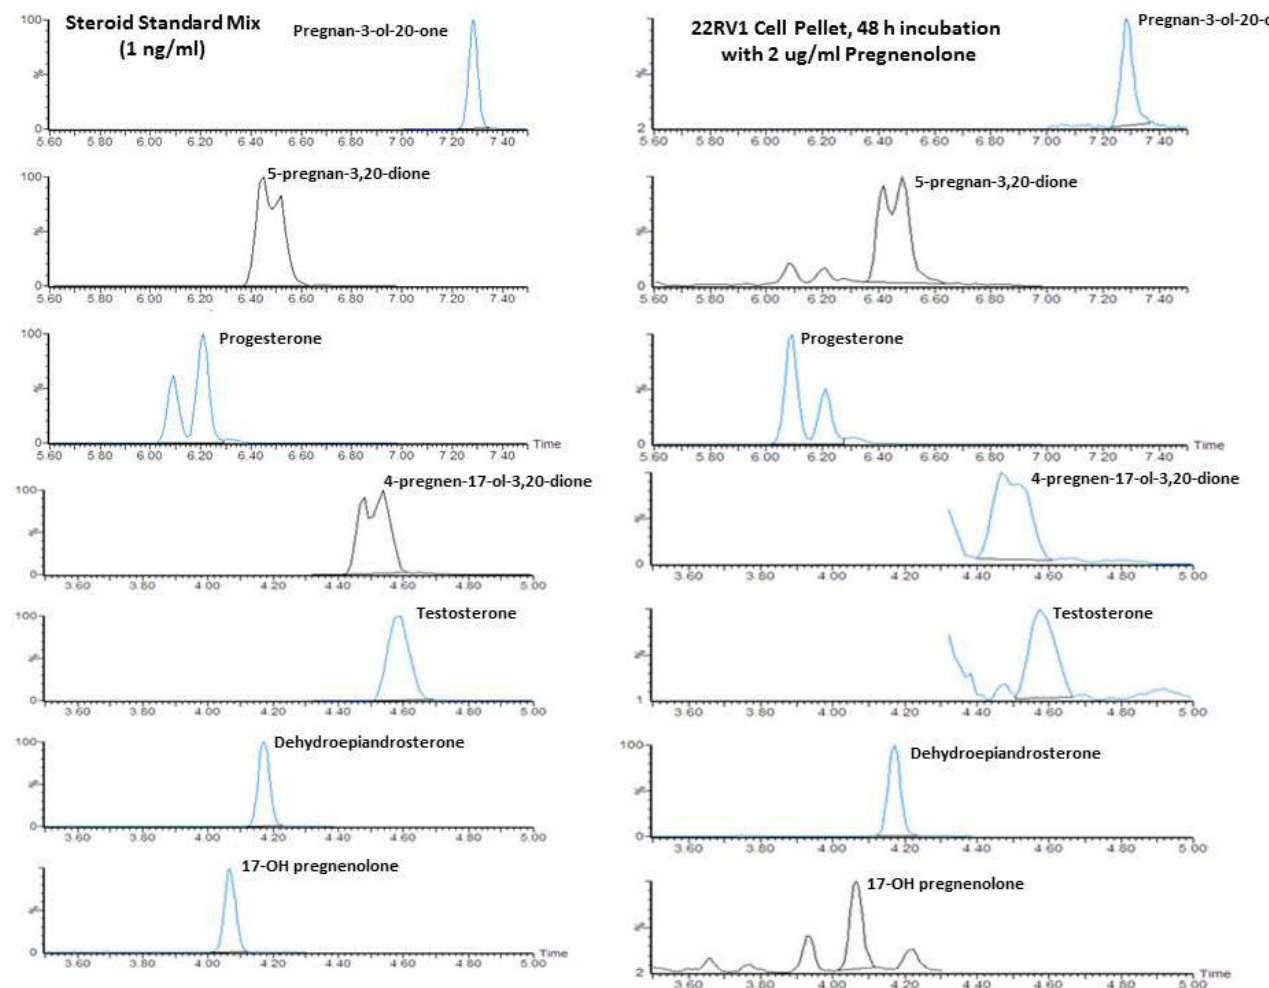
Figure 1. Representative liquid chromatography-mass spectrometry (LC/MS) chromatograms showing steroid standards (1 ng/mL) and the formation of steroids following the incubation of 22Rv1 cells with 2 μg/mL pregnenolone for 48 h (measured in the cell pellet).